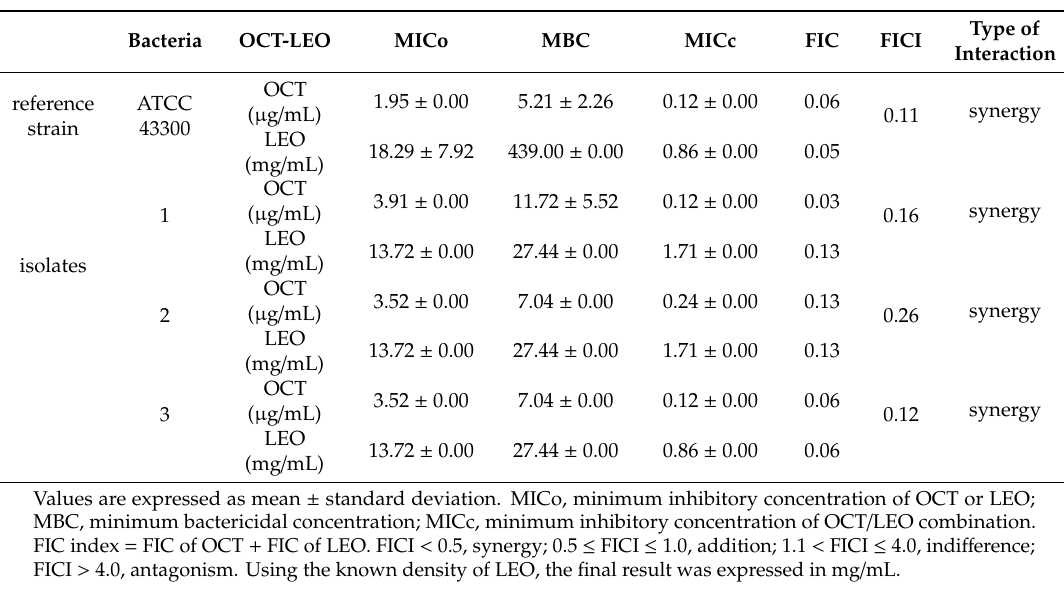
Table 2. Fractional inhibitory concentration (FIC) and FIC indices (FICI) of octenidine dihydrochloride (OCT)—lavender essential oil (LEO) pairs against methicillin-resistant Staphylococcus aureus (MRSA) strains.